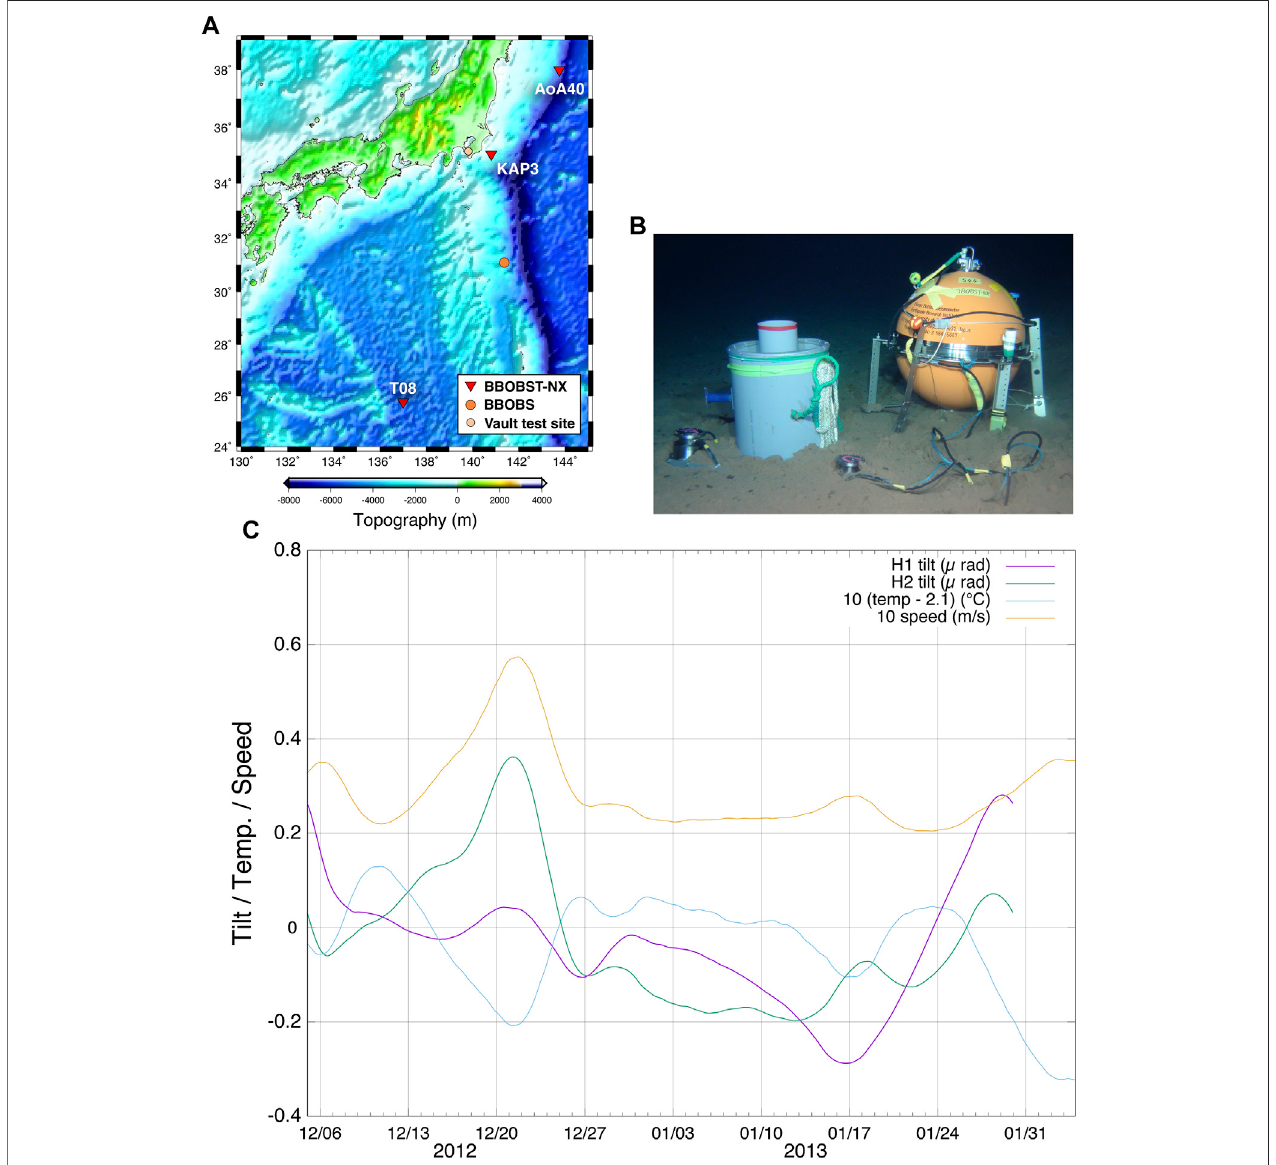
FIGURE 6 | The fi rst sea fl oor test of the BBOBST-NX. (A) The map shows all fi ve sites mentioned in this paper. At the T08 site, where we have performed several observations, the fi rst test wasconducted. (B) Therecordingunit and alarge gray tube were located close to the sensor unit for thepreparation ofNX-2G development, to examine in fl uence on the data by these objects. The tube was originally designed as the base for the recording unit, but we failed to place the unit on the tube. The OBDCwasalsodeployedata100 mdistance. (C) Resultsofthetiltchangefor2 monthsbytheBBOBST-NXandwatertemperatureandbottomcurrentspeedby the OBDC. All data were resampled with 1 h intervals and moving-averaged (1 week). The tilt data were processed using the Baytap08